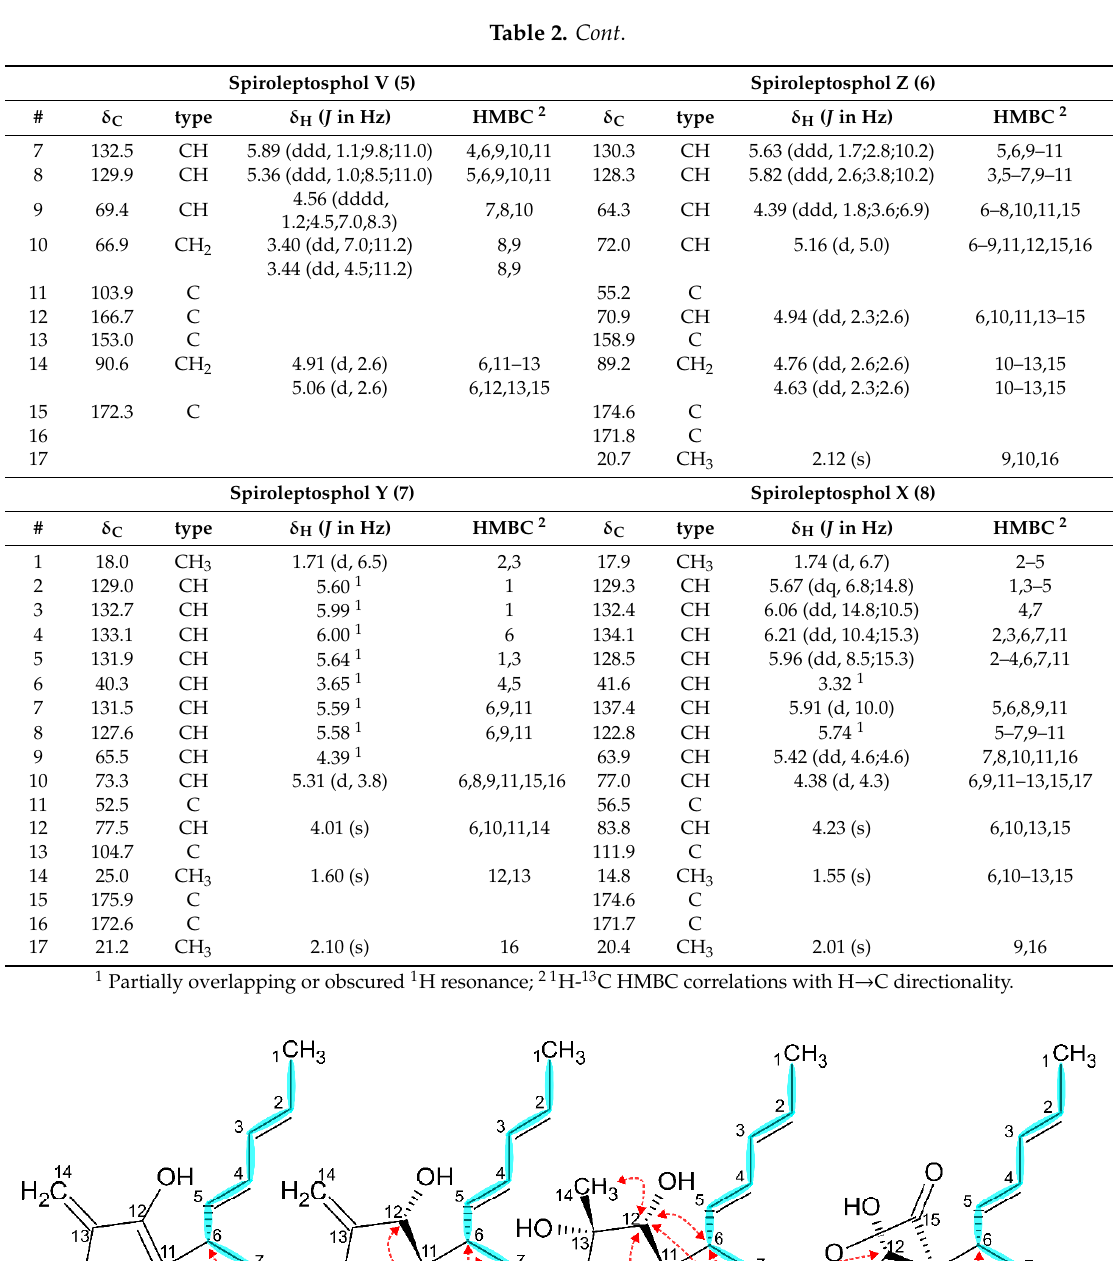
Figure 5. Calculated (red) and experimental (black) VCD (top) and IR (bottom) spectra of 7 , and the structure including annotation of the absolute configuration of 7 as used for the calculation. For easier orientation, corresponding bands are numbered. The large shift between the carbonyl vibrations (1 and 1’, calc. vs. exp.) is caused by the approximate solvent model in the calculations; the other two most intense IR bands (5 and 8) largely involve OH bending and CO stretching. As can be seen, the VCD experimental signal is rather noisy, due to the limited sample amount, and in some regions hampered by the absorption of the methanol (deuterated) solvent. Nevertheless, signs of all assignable VCD bands are consistently reproduced by the theory. The absolute configuration of the remaining compounds 1 – 6 and 8 are assumed to be identical to 7 , since the relative configuration for these are conserved it would not be likely that the fungi produces enantiomers where each chiral center would be inverted. Interestingly, the absolute